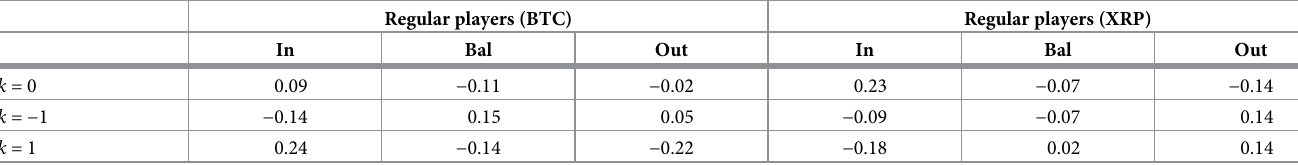
Table 6. Correlation between the time difference of price, Δ p ( t ), and the time difference of the number of Total, In, Bal, and Out regular players, Δ N i ( t ). k represents the lag time. For example, k = 1 means the correlation between Δ p ( t − 1) and Δ N i ( t ).